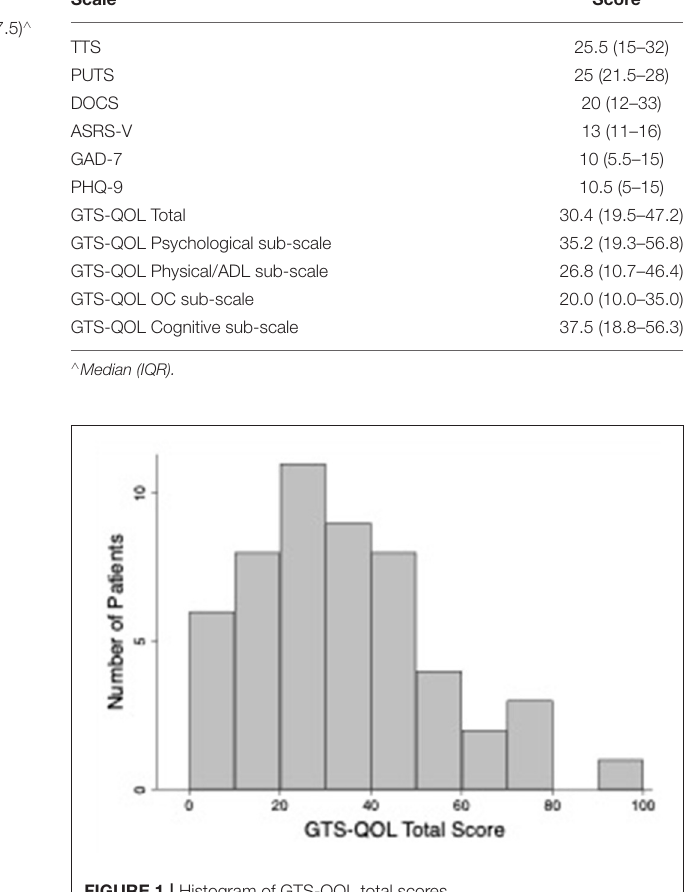
FIGURE 1 | Histogram of GTS-QOL total scores.